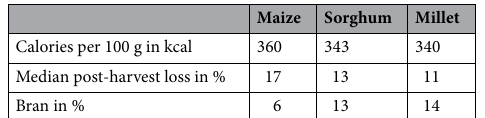
Table 1. Calories 48 , median post-harvest losses per crop 49 and share of bran 48 .